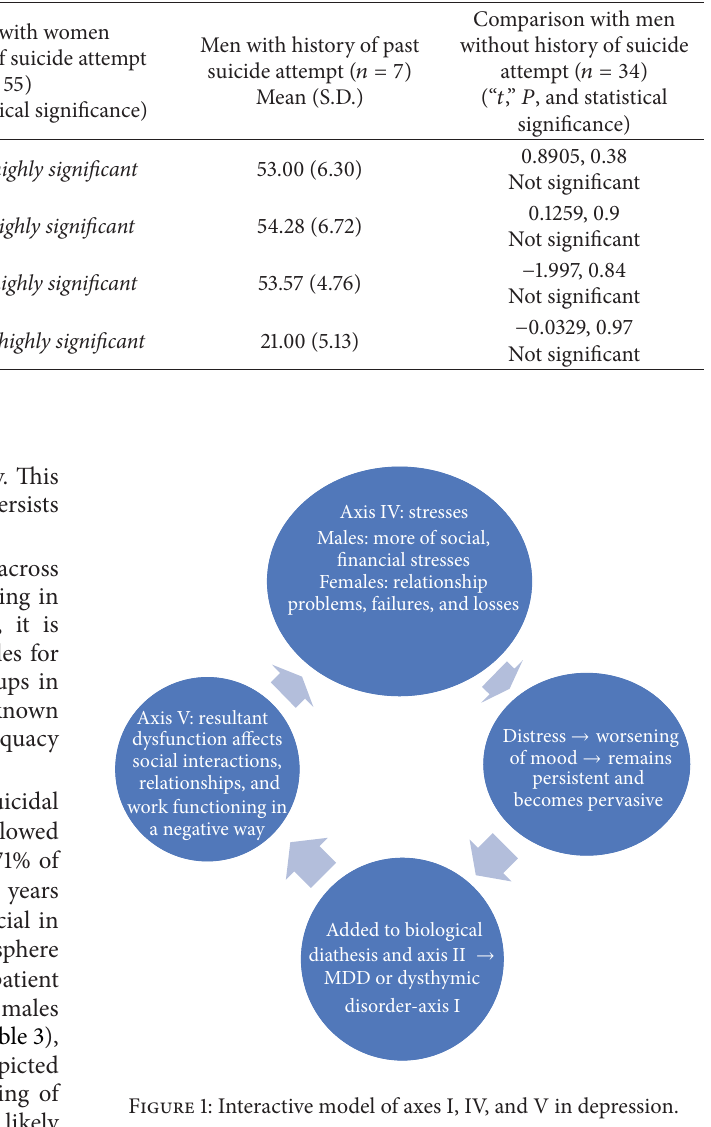
Table 5: Association between suicide attempt and scores of psychopathology and functioning.